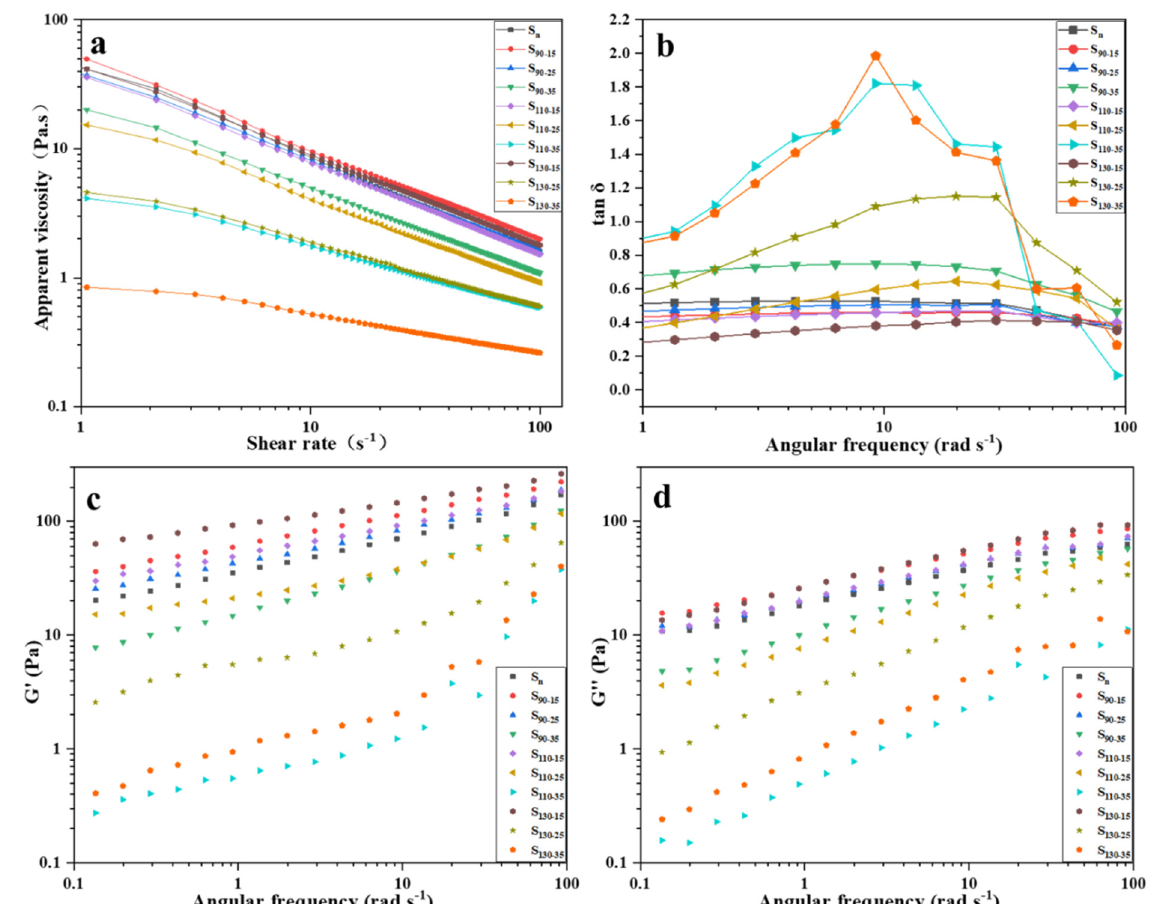
Figure 1. Rheological properties of native and HMT HB flours. ( a ) Apparent viscosity of HB flour gel; ( b ) tan δ ; ( c ) storage modulus; ( d ) lose modulus. S n indicates native HB flour; S 90 − 15 , S 90 − 25 , S 90 − 35 indicate that the heating temperature of HB flour is 90 °C; S 110 − 15 , S 110 − 25 , S 110 − 35 indicate that the heating temperature of HB flour is 110 °C; S 130 − 15 , S 130 − 25 , S 130 − 35 indicate that the heating temperature of HB flour is 130 °C; S 90 − 15 , S 110 − 15 , S 130 − 15 indicate that the moisture content of HB flour is 15%; S 90 − 25 , S 110 − 25 , S 130 − 25 indicate that the moisture content of HB flour is 25%; S 90 − 35 , S 110 − 35 , S 130 − 35 indicate that the moisture content of HB flour is 35%; G ′ , storage modulus; G ″ , loss modulus; tan δ , loss tangent.